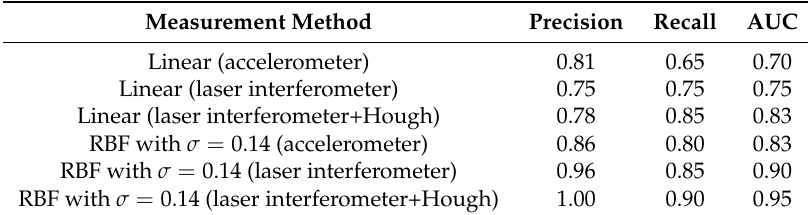
Figure 10. ROC curve comparison for different test datasets. Table 2. Performance evaluation of SVM models for different test